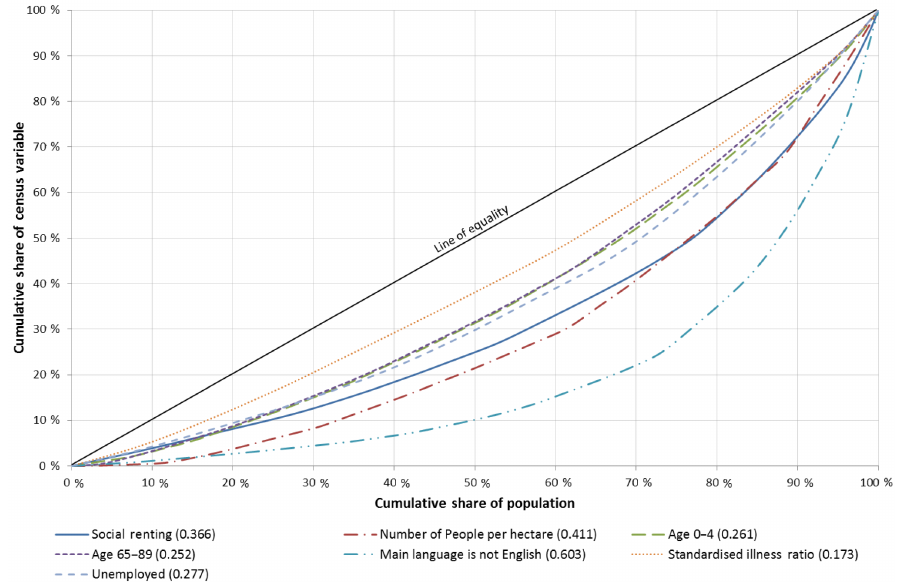
Figure 3. Lorenz curves of Output Area Classification (OAC) selected to assess social vulnerability to flooding. Gini coefficient is shown within the graph